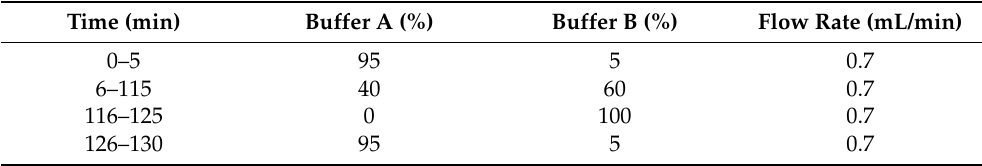
Table 3. Elution procedure of